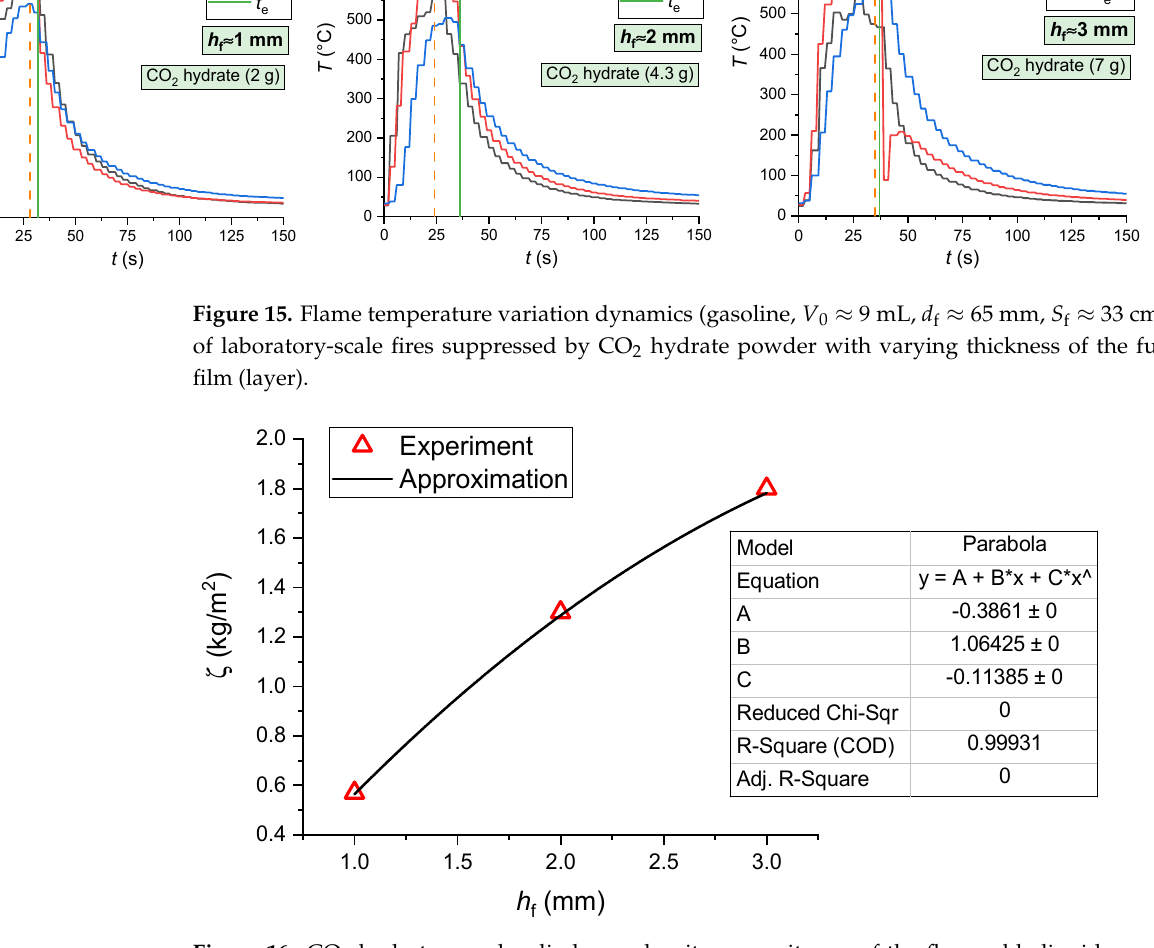
Figure 16. CO 2 hydrate powder discharge density per unit area of the flammable liquid versus the thickness of the liquid layer necessary and sufficient for the suppression of a laboratory-scale class B fire.